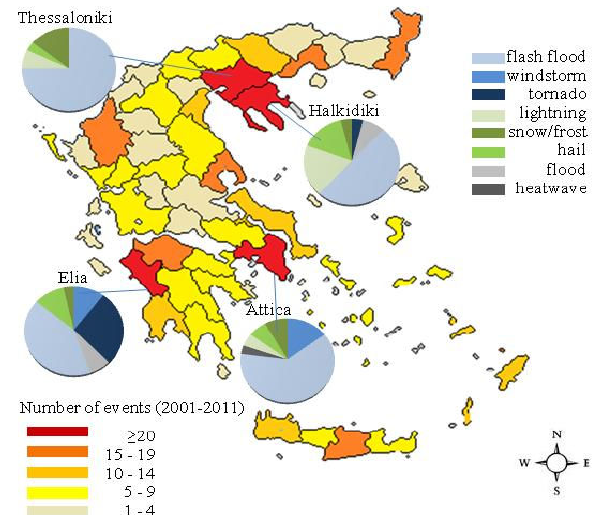
Fig. 12. Frequency of high-impact weather events in Greece by pre- fecture, between 2001 and 2011. Distribution by phenomenon for the most affected